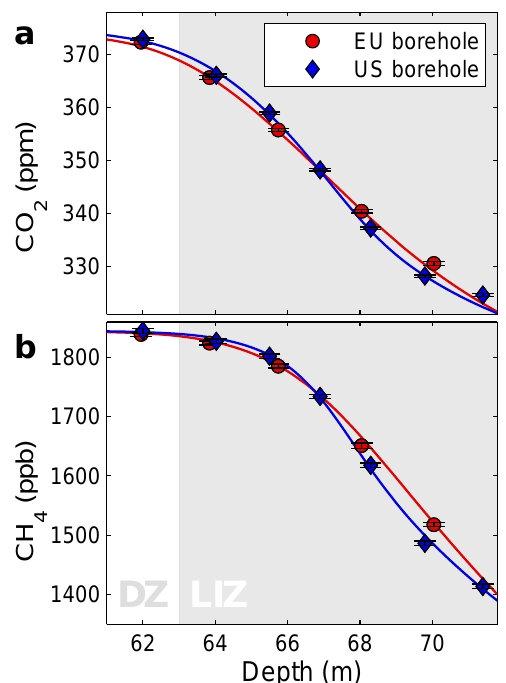
Table 1. Overview of firn air data used in this study. Acronyms rep-